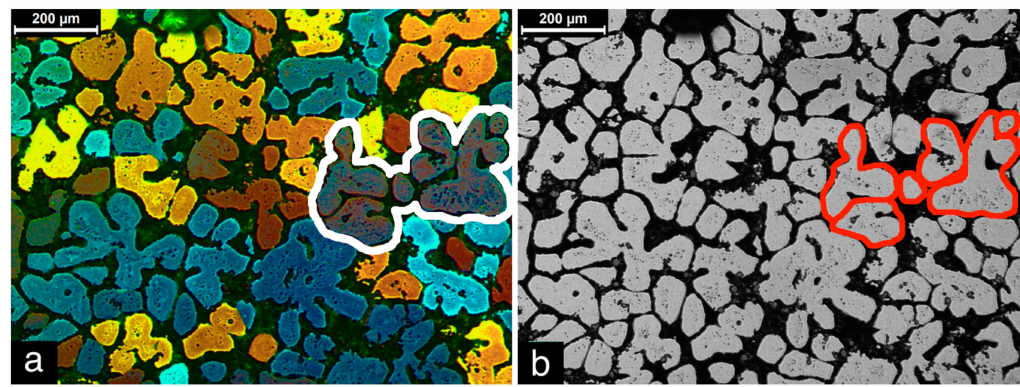
Figure 1. Micrograph of the B319+Fe alloy. ( a ) Polarized light optical micrograph highlighting grains (a single grain is outlined in white); ( b ) conventional B&W optical micrograph highlighting globules (six globules of the same grain are outlined in